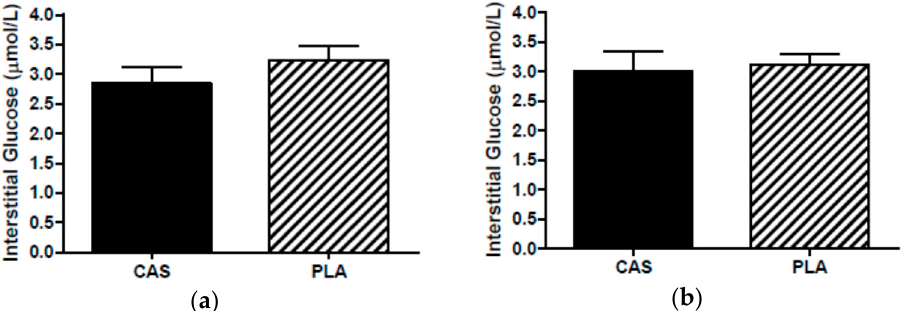
Figure 3. Interstitial glucose ( a ) overnight during sleep and ( b ) the morning after consumption of casein (CAS) or placebo (PLA); n = 11, Mean ± SEM.